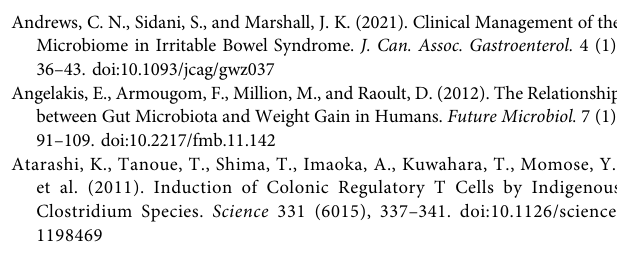
molecules on the GM modulation in humans and animal models of